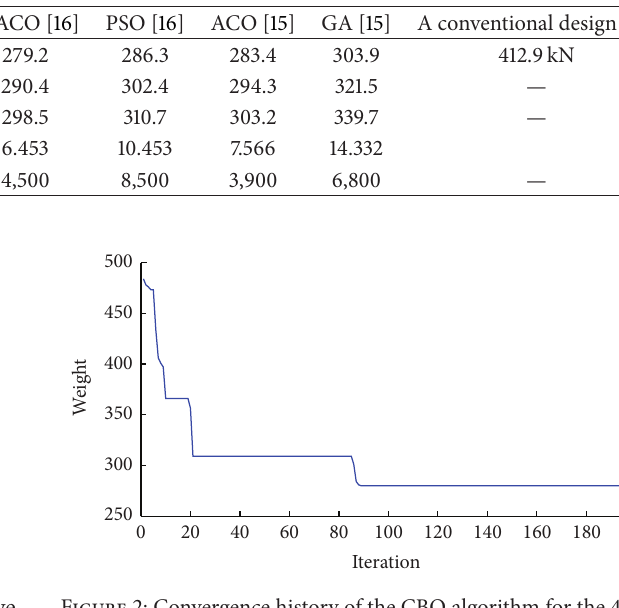
Figure 2: Convergence history of the CBO algorithm for the 4-bay 3-story